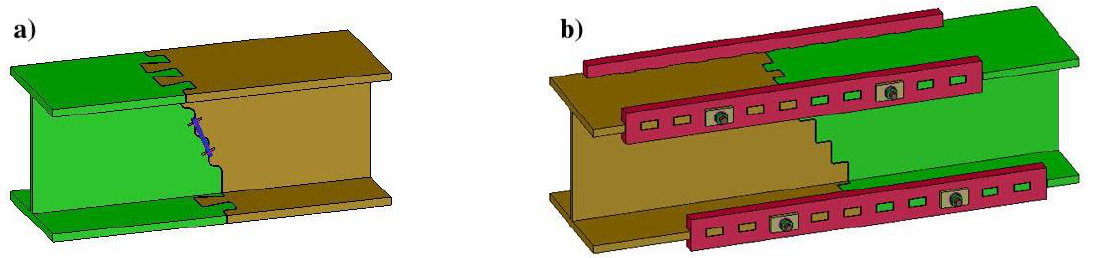
Figure 1. Intermeshed steel connection (ISC): ( a ) front ISC; ( b ) side SC.